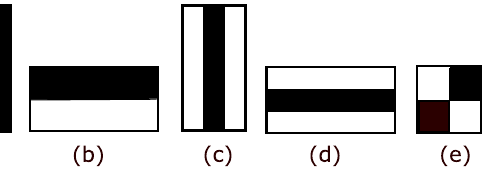
Figure 3. Types of Haar-like features. ( a ) Left-right. ( b ) Top-bottom. ( c ) Vertical-middle. ( d ) Horizontal-middle. ( e )